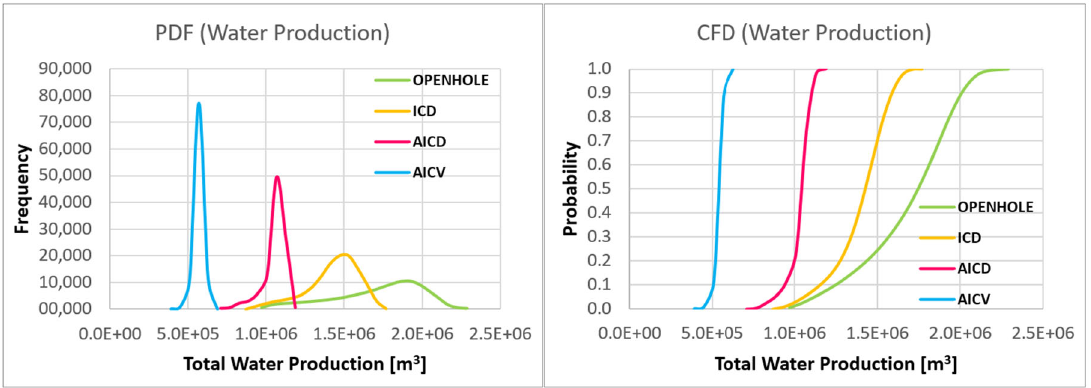
Figure 15. Probability and cumulative distribution function for water production after 10 years.